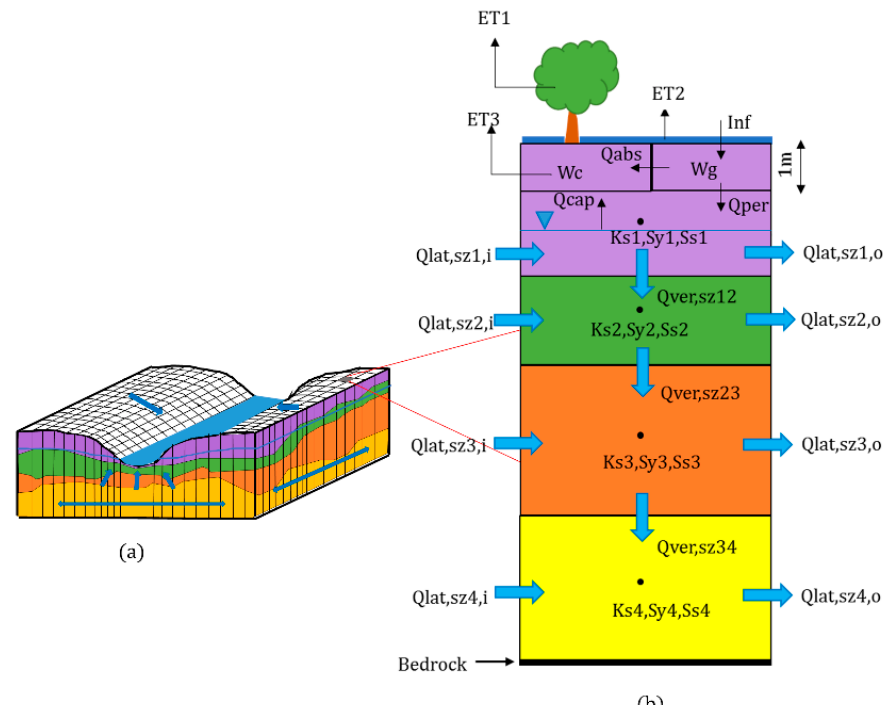
Figure 5. ( a ) Domain discretization in MOBIDIC-MODFLOW and in MIKE SHE; ( b ) schematic diagram of the hydrological fluxes in MOBIDIC-MODFLOW. Inf: Infiltration, ET1: Canopy transpiration, ET2: Surface water evaporation, ET3: Root transpiration, Wg: Gravity reservoir, Wc: